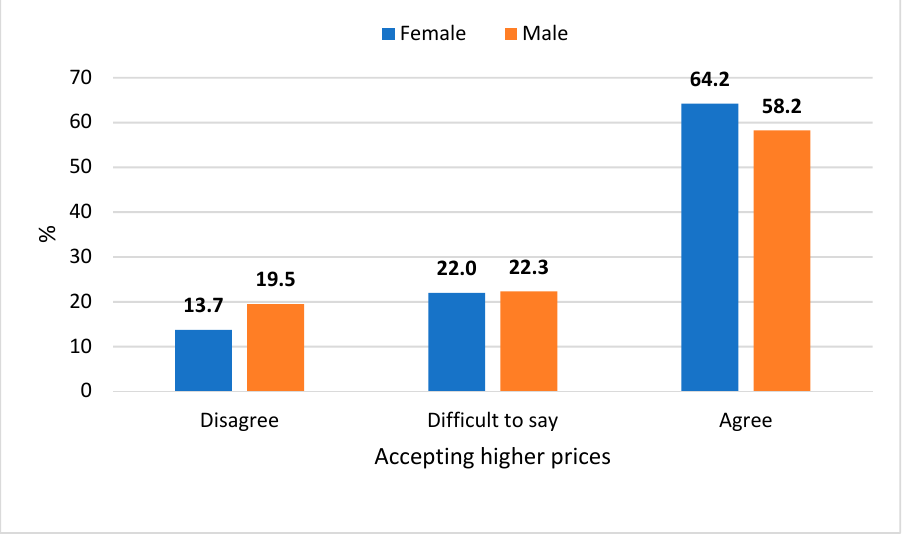
Figure 1. Percentage frequency distribution of accepting higher prices for products that do not cause environmental damage among women and men.